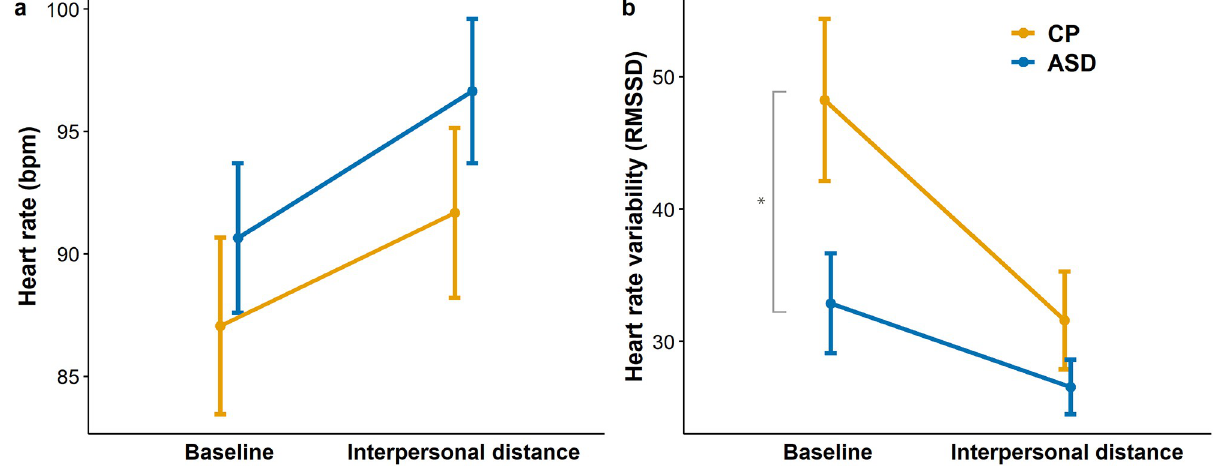
Fig 3. Heart rate and heart rate variability. Panel A: Baseline and reactive (interpersonal conditions) heart rate in beat per minute (bpm). Panel B: Baseline and reactive (interpersonal conditions) heart rate variability (RMSSD). Error bars: standard error of the mean. Asterix indicates significant group difference. Orange line: neurotypical participants, blue line: participants with